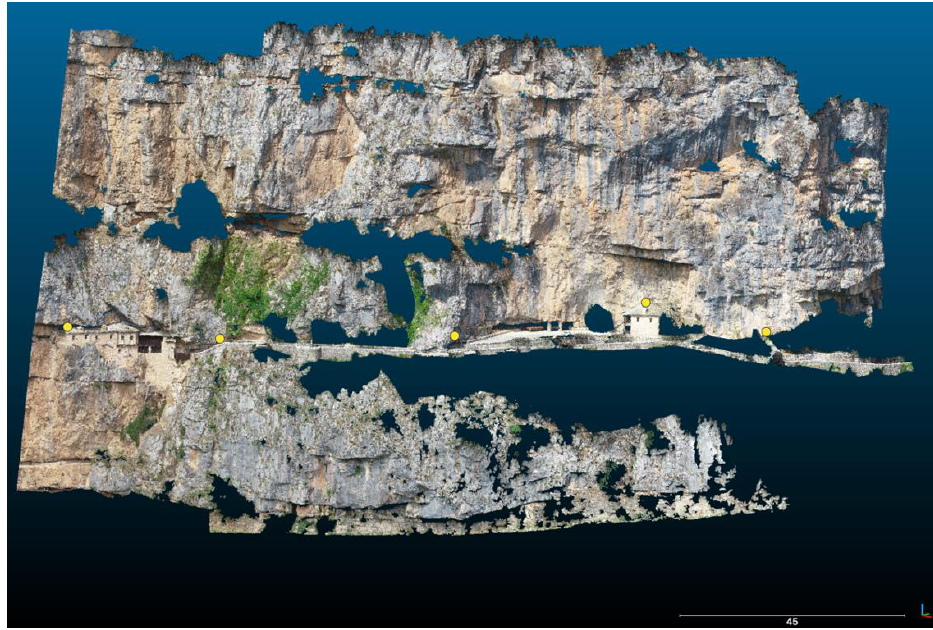
Figure 3. The constructed 3D point cloud model with used GCPs shown as yellow dots.